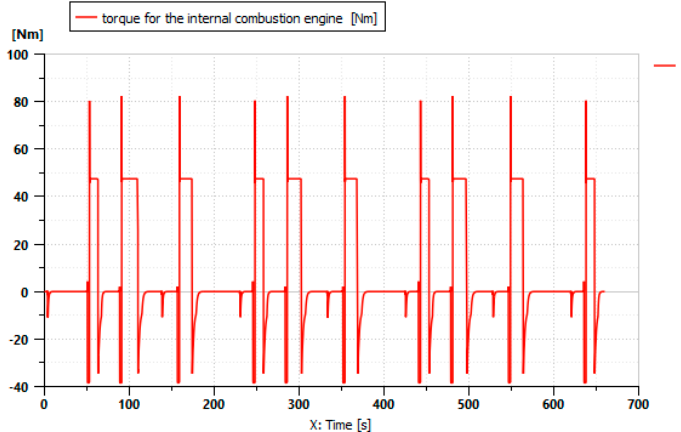
Figure 18. Thermal motor torque.